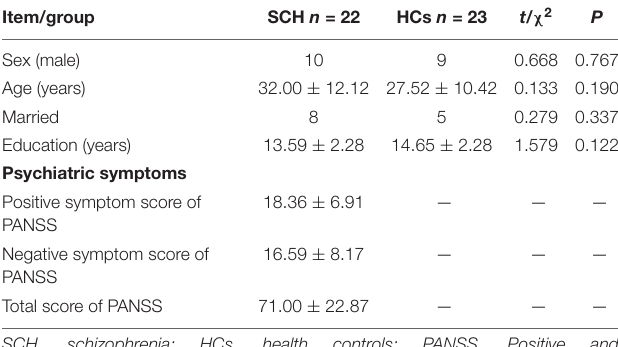
TABLE 1 | Demographic and clinical characteristics of schizophrenia and control.